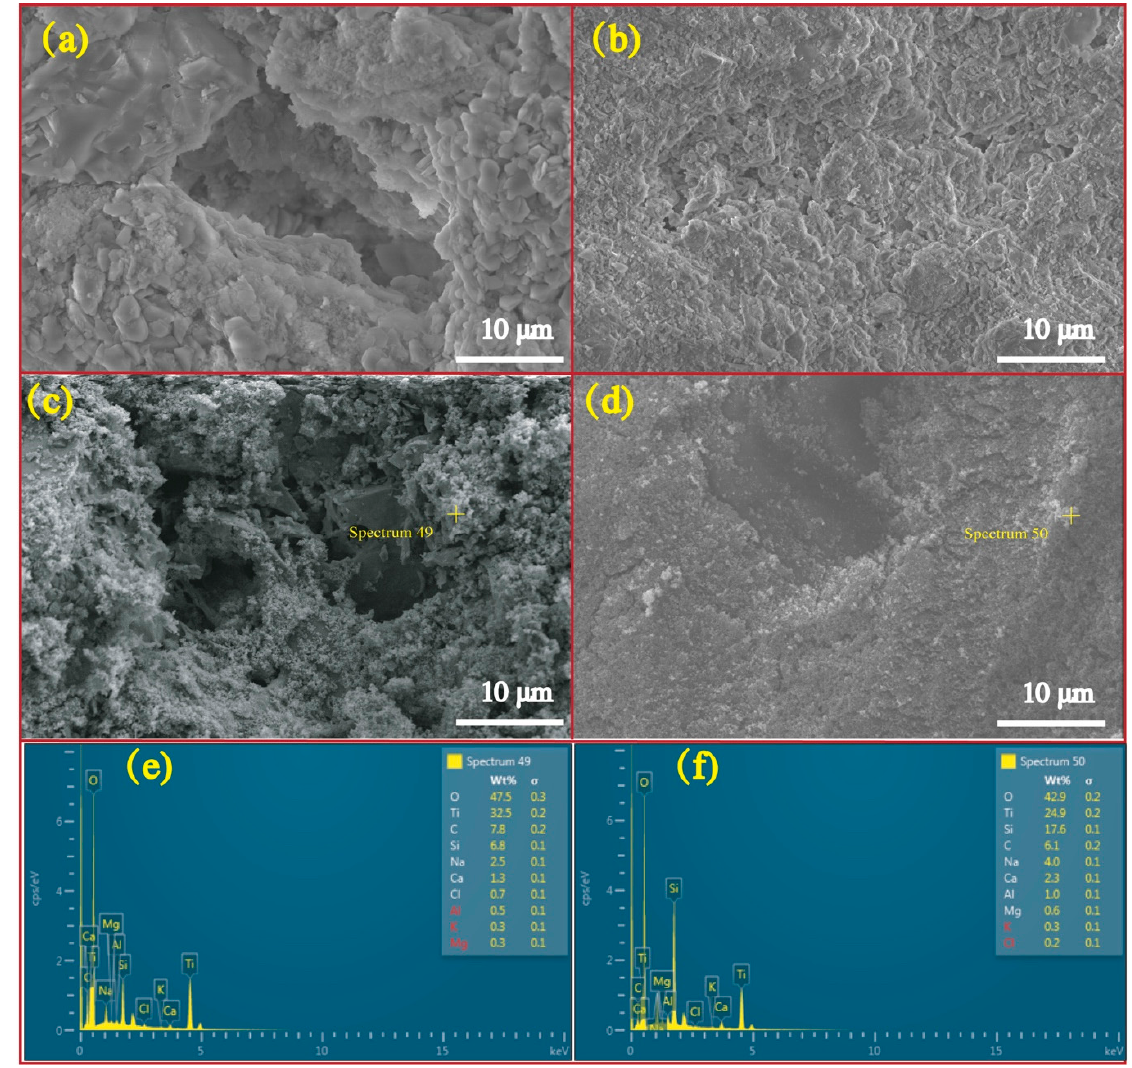
Figure 5. Micrograph and EDS profiles: ( a ) micrograph of pure FRA; ( b ) micrograph of pure RS; ( c ) micrograph of NT@FRA; ( d ) micrograph of NT@RS; ( e ) EDS profile of NT@FRA at selected point; and